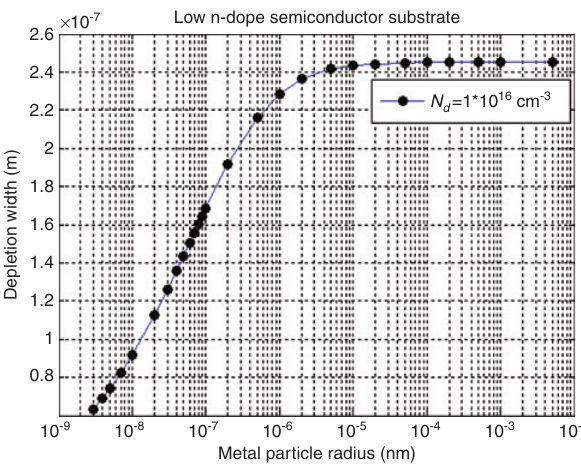
Figure 3: The depletion width values for model 1 as the metal radius increases from 3 nm to 50 μ m for low n-doped substrate. The horizontal scale is logarithmic.